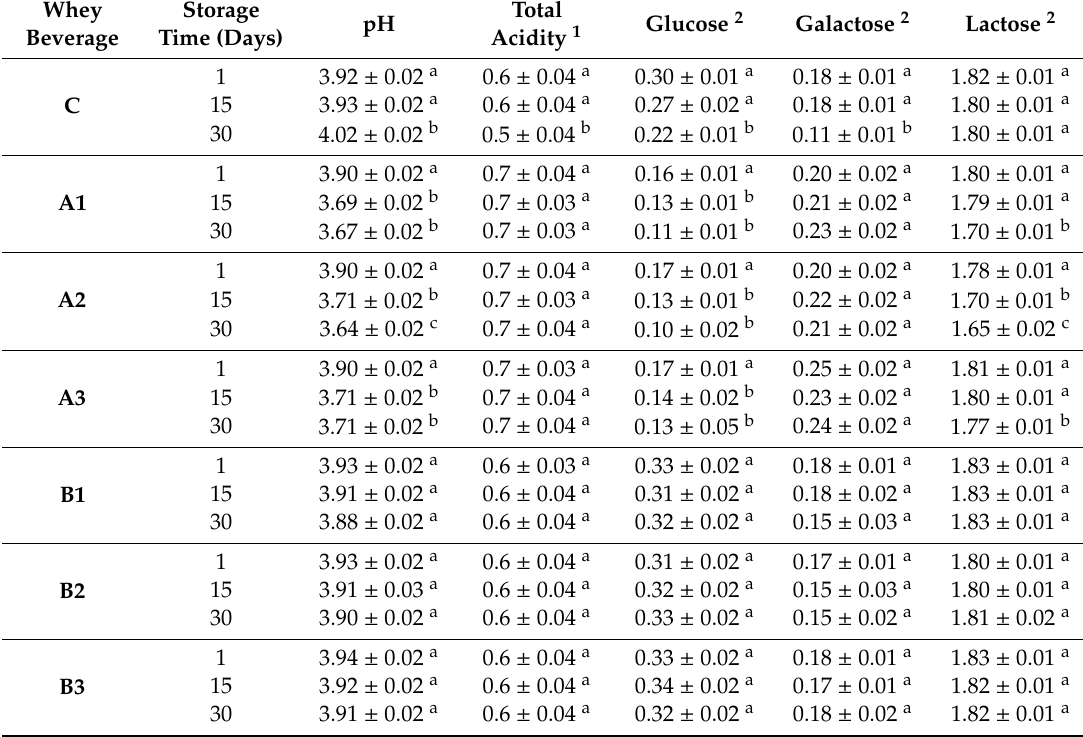
Table 1. Determination of pH, total acidity, glucose, galactose, and lactose content of whey beverages during 30 days of refrigerated (4 ◦ C)